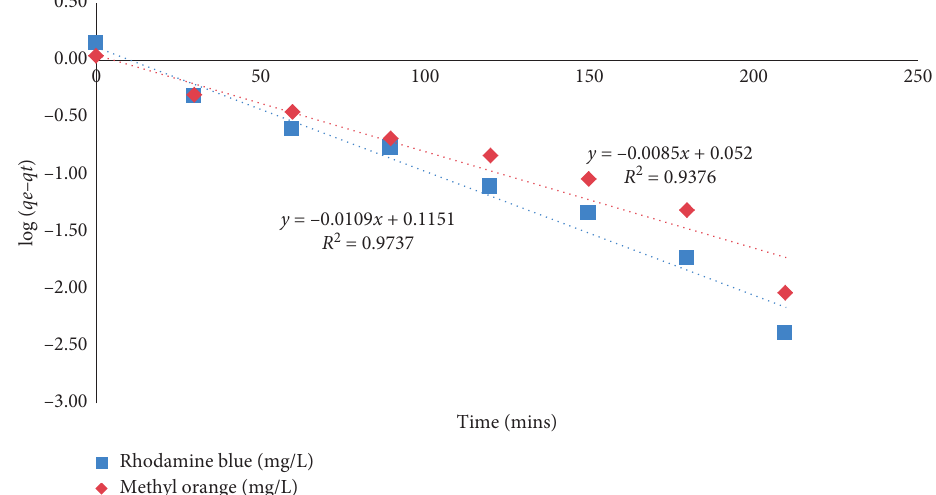
Figure 16: A pseudo-first-order degradation process for rhodamine blue and methyl